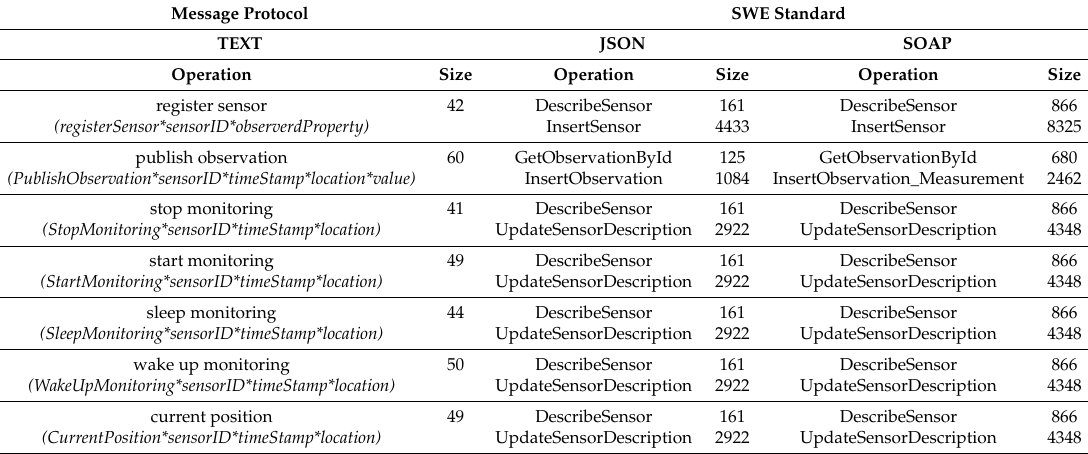
Table 3. Size in Bytes